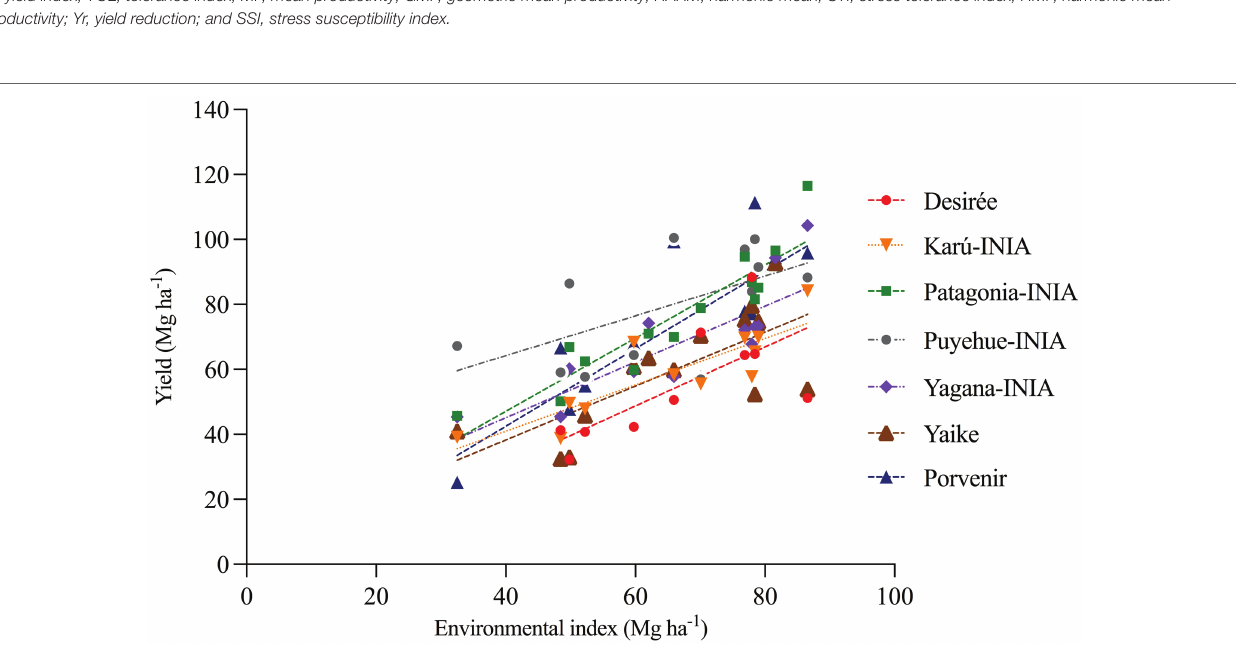
FIGURE 9 | Relationship between yield and environmental index for seven potato varieties.